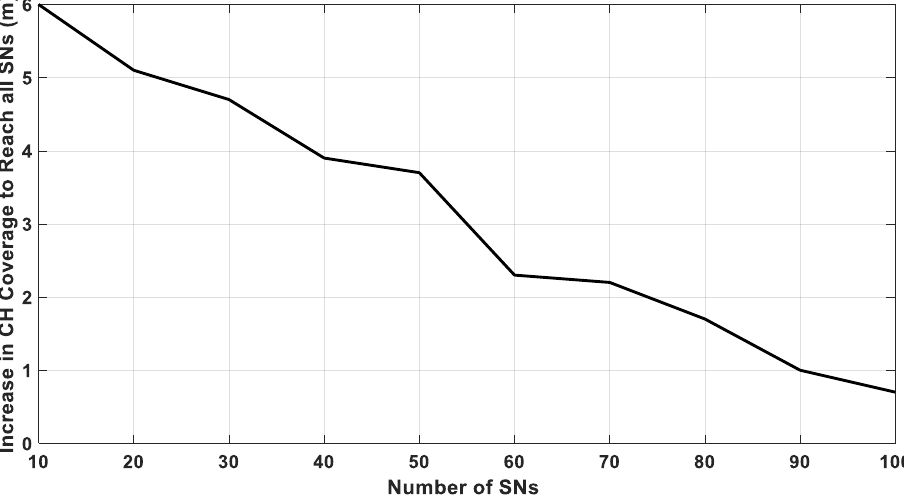
Figure 9. Coverage in meter that the CH needs to adjust to access all sensor nodes.